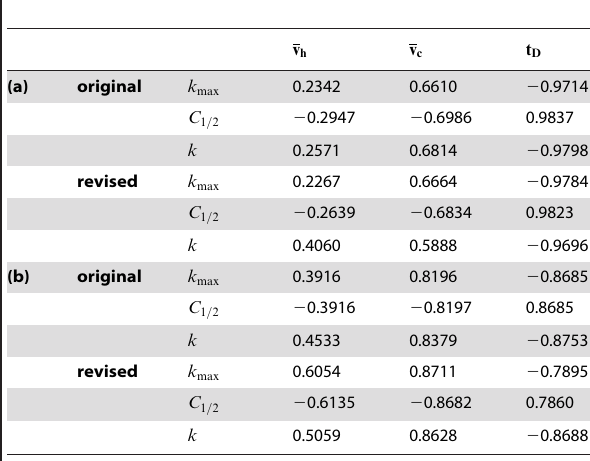
Table 2. Correlation between killing rate constants and properties of simulated